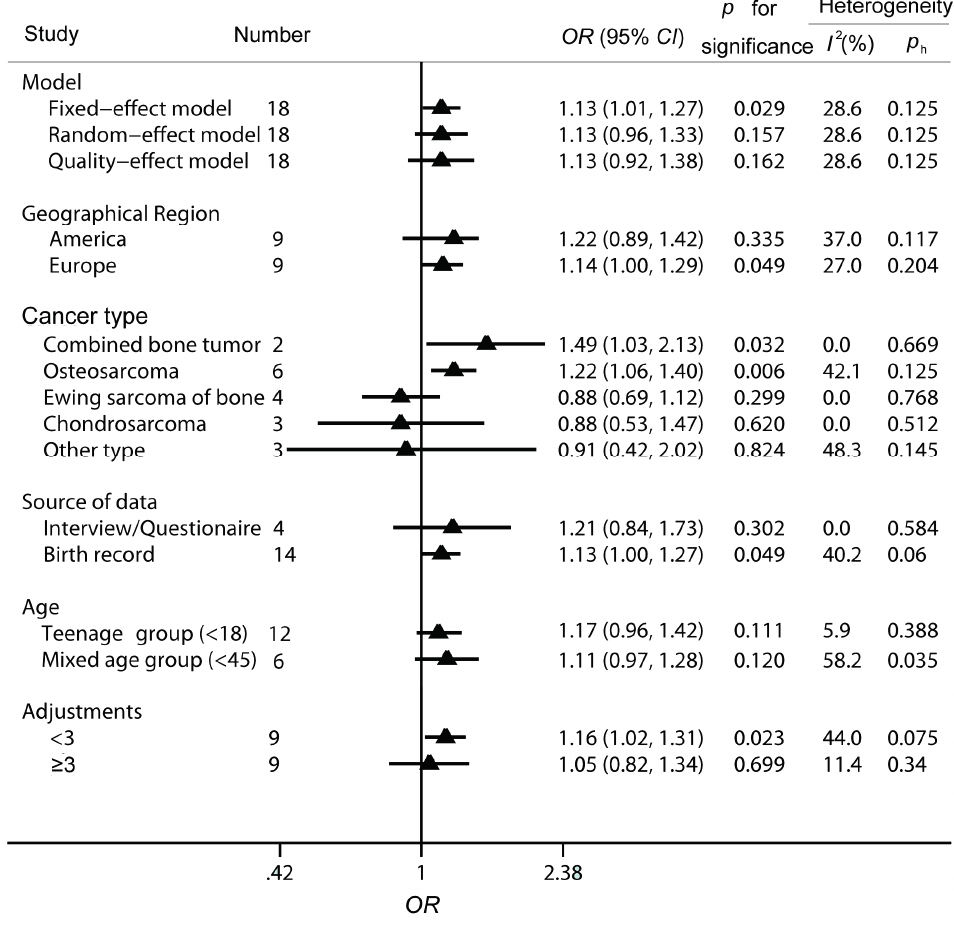
Figure 5. Subgroup analysis of ORs for bone tumor related to high birth weight. The term “ ≥ 3” means the study was adjusted by either age or